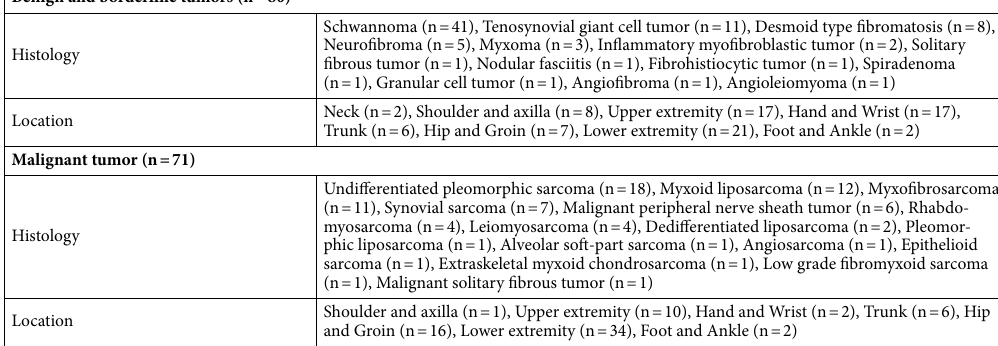
Table 1. Various histology of soft tissue sarcoma of the included